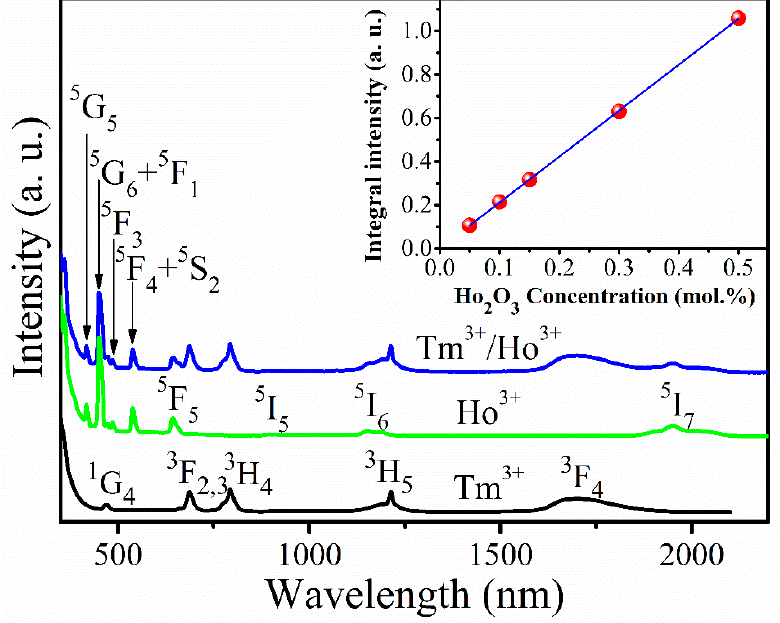
Figure 1. Absorption spectra of TGBT-1, TGBH-0.5, and TGBTH-0.5 glasses. The inset shows integral absorption intensity at 538 nm as a function of Ho 2 O 3